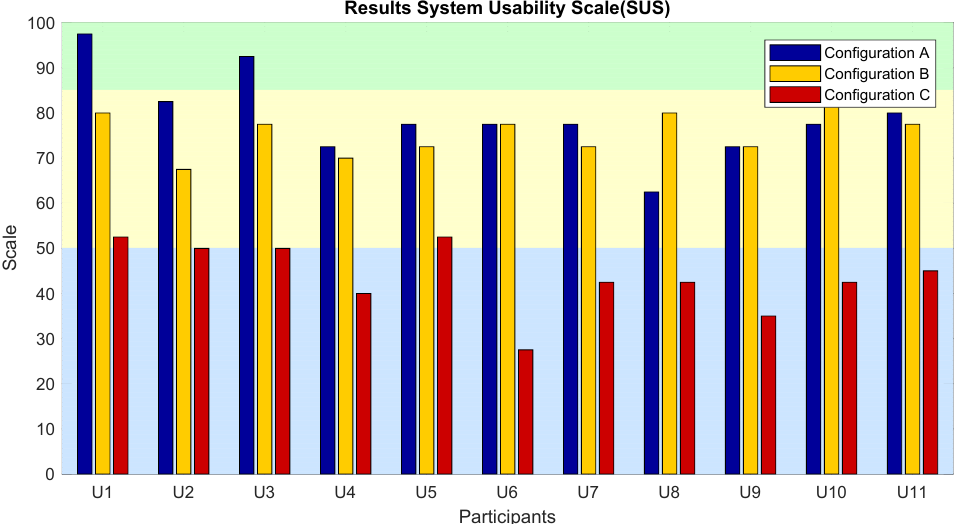
Figure 12. Results of the tests carried out using the System Usability Scale, for each of the participants who carried out the experiments. The color background of this graph shows three different scoring areas: light blue for poor usability (SUS score < 50), light yellow for good usability (SUS score between 50 and 85), and light green for excellent usability (SUS score > 85).